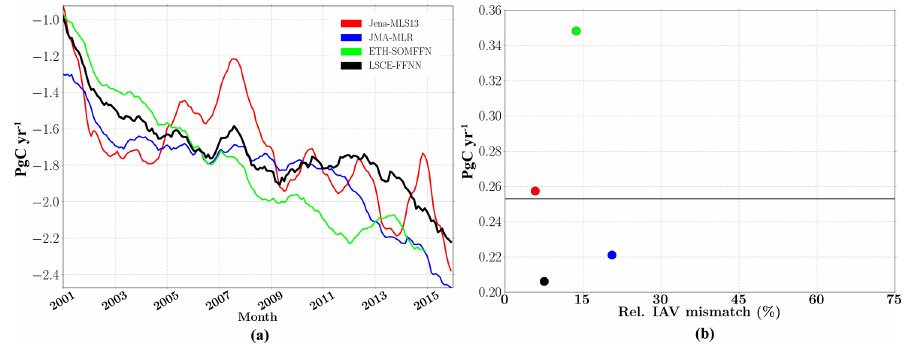
Figure 6. (a) Interannual global ocean sea–air CO 2 flux (12-month running mean); (b) the amplitude of interannual CO 2 flux plotted against the relative IAV mismatch amplitude. The weighted mean is given as a horizontal